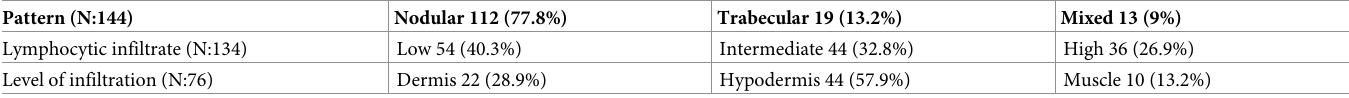
Table 2. Basic histological variables. Pattern